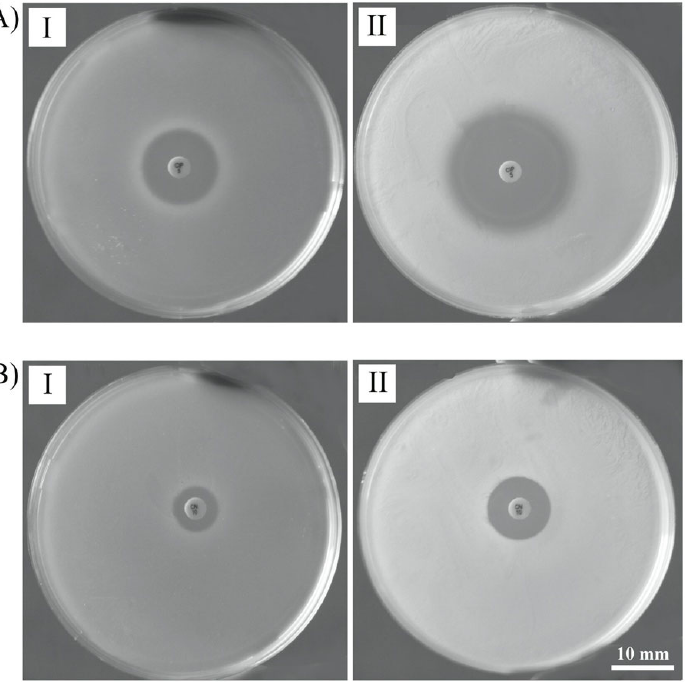
Figure 6. Changes in susceptibility of Pf4 uninfected ( I ) and PF ‐ infected ( II ) strain LESB58 to CIP ( A ) and GEN ( B ). Table 1. MIC of antibiotics for uninfected and Pf4 ‐ infected P. aeruginosa strains.